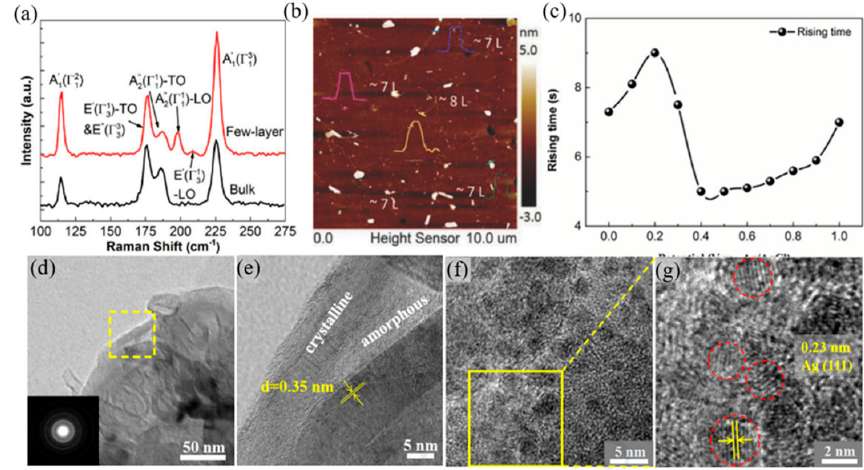
Figure 27. ( a ) Raman atlas of InSe nanosheets after InSe blocks and LPE. ( b ) AFM diagram of InSe nanosheet. ( c ) Response time of PEC type InSe PD under 0–1 V bias in 2 M KOH electrolyte [320]. Copyright 2017 Wiley-VCH Verlag. ( d ) Transmission electron microscope (TEM) photograph of WO 3-x materials. ( e ) High resolution TEM photograph of the region in ( d ). ( f ) High resolution TEM photograph of Ag/WO 3-x heterostructure. ( g ) High resolution TEM photograph of the region in ( f ) [321]. Copyright 2018 Elsevier.